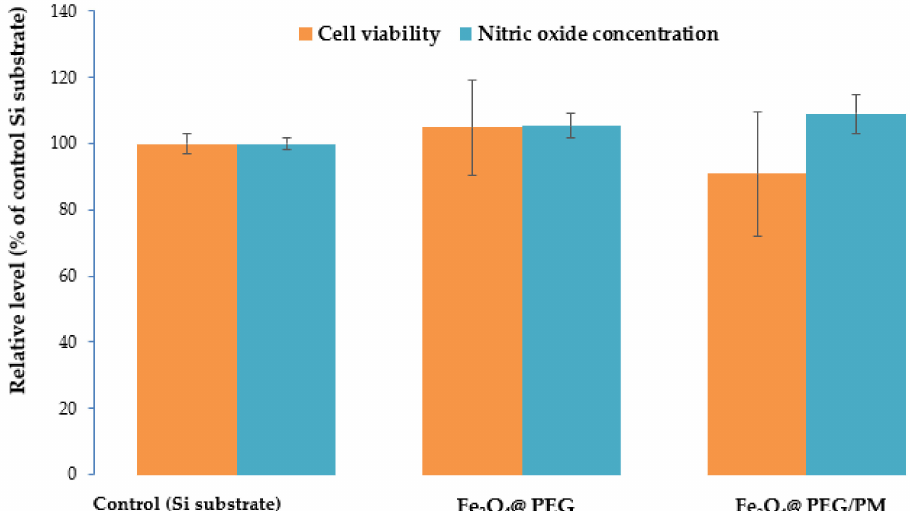
Figure 12. Cell viability and nitric oxide concentration after 24 h of incubation of MC3T3-E1 os- teoblasts with Fe 3 O 4 @PEG and Fe 3 O 4 @PEG/PM samples. The measurements were performed in triplicate (n = 3) and the results were presented as average ± standard deviation relative to the